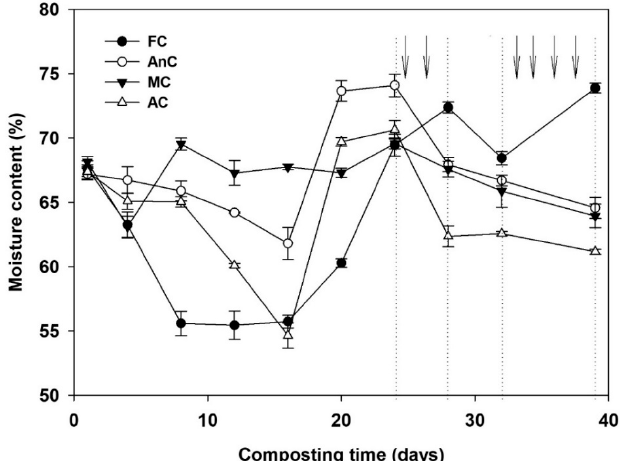
Figure 2. Changes in moisture content of the composting material during dairy manure composting. FC—farmer compost; AnC—anaerobic compost; MC—mixed compost; AC—aerobic compost. (The arrow indicates that there was